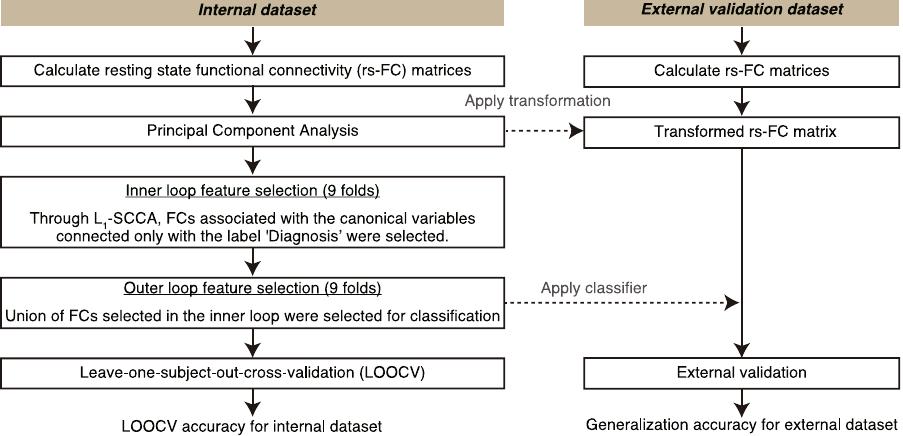
Figure 1. Schematic diagram of the procedure for selecting FCs as an OCD biomarker and assessing their predictive power. Rs-FC matrices were processed through the cascading feature selection procedure. Left-out participants and all participants in the external validation dataset were classified based on the classifier derived from the rs-FC matrix from the other